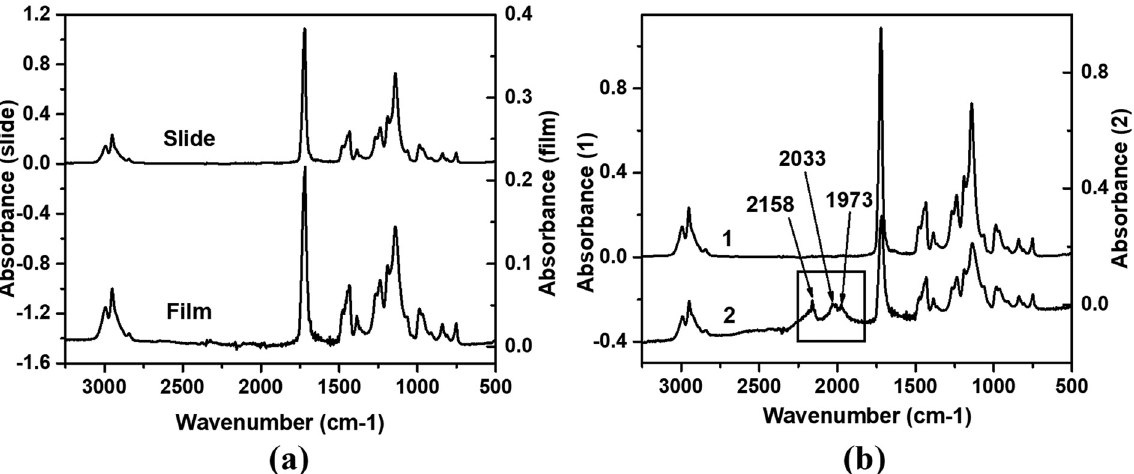
Figure 12: ( a ) FTIR absorption spectra of PMMA slide used as a PLD target and deposited fi lm ( Figures 9 through 11 ) . ( b ) FTIR spectra of ( 1 ) PMMA slide ( target ) and ( 2 ) the material on the edge of the cavity created in the PMMA slide by the laser beam during ablation. Three new absorption peaks in the box can be attributed to the stretch vibration modes of terminal alkynes R – C ^ C – H ( 2,140 – 2,100 cm − 1 ) , R – N ] C – S ( 2,140 – 1,990 cm − 1 ) , R – N – C ( 2,165 – 2,110 cm − 1 ) , C ^ N ( cyanides, 2,019 cm − 1 ) [ 59 ]